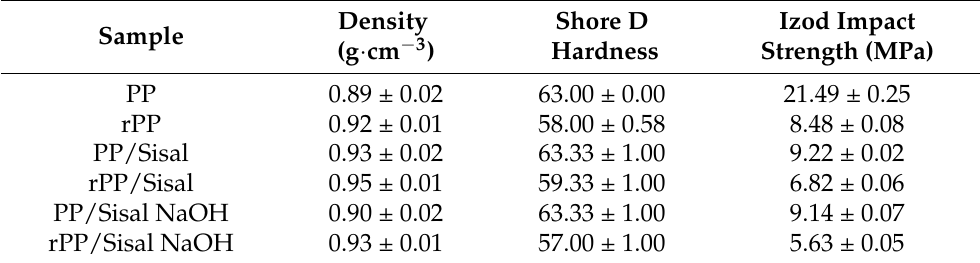
Table 3. Density, Shore D hardness and Izod Impact of processed